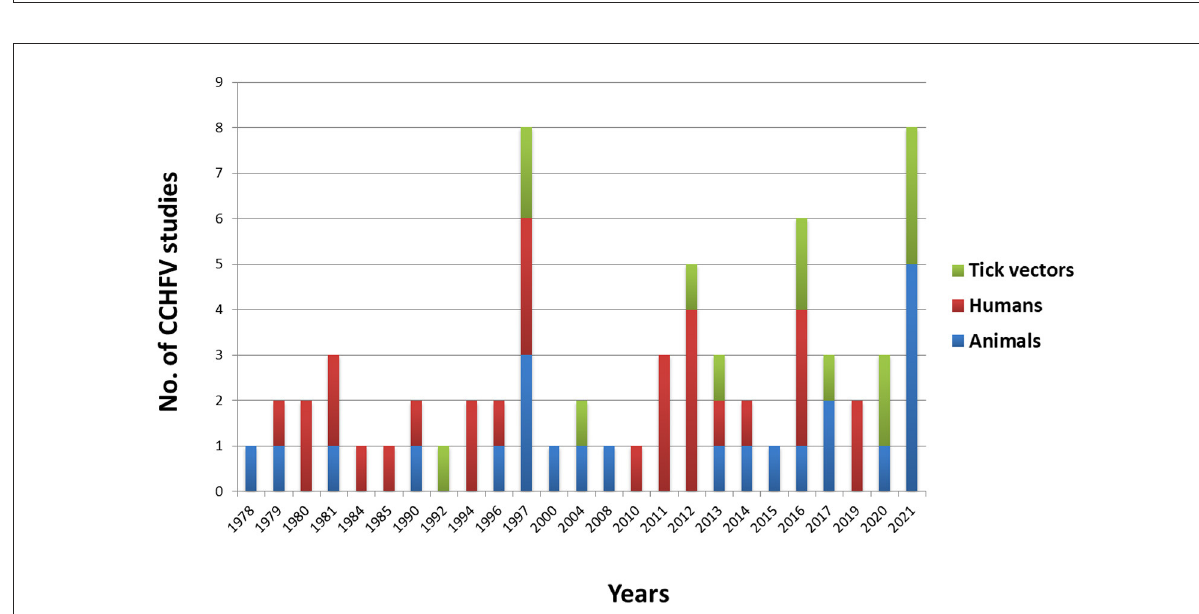
FIGURE3 CCHFV reported in ticks, humans and animals in the Arab world from 1978–2021.